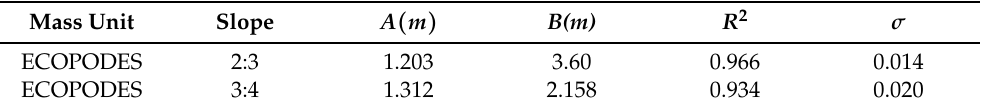
Table 4. Coefficients A ( m ) and B ( m ) to be included in Equation (3) refitted by Buccino et al. [49]. Best fit values R 2 and σ are reported for each front slope.